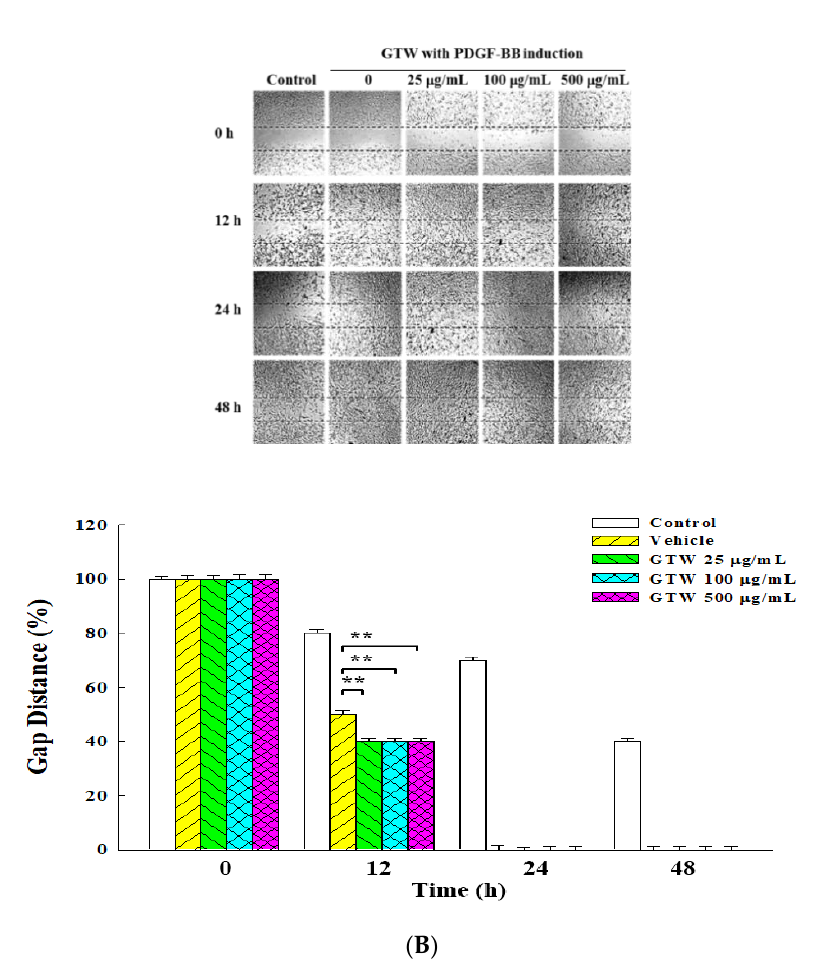
Figure 2. Inhibitory effects of GTE and GTW on the cell motility of PDGF-BB-stimulated VSMCs. Effect of the treatment time at various concentrations of GTE ( A ) and GTW ( B ) on the cell motility under the stimulation with 50 ng/mL of PDGF-BB. The control group was the cell motility of VSMCs without PDGF-BB stimulation. Data were estimated from five replicate experiments. Significant differences compared with the vehicle (group 0) are denoted as ** p < 0.01 and *** p < 0.001.